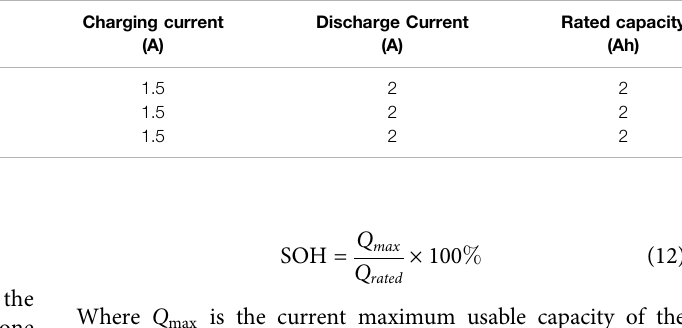
TABLE 1 | Experimental conditions of batteries #2 and